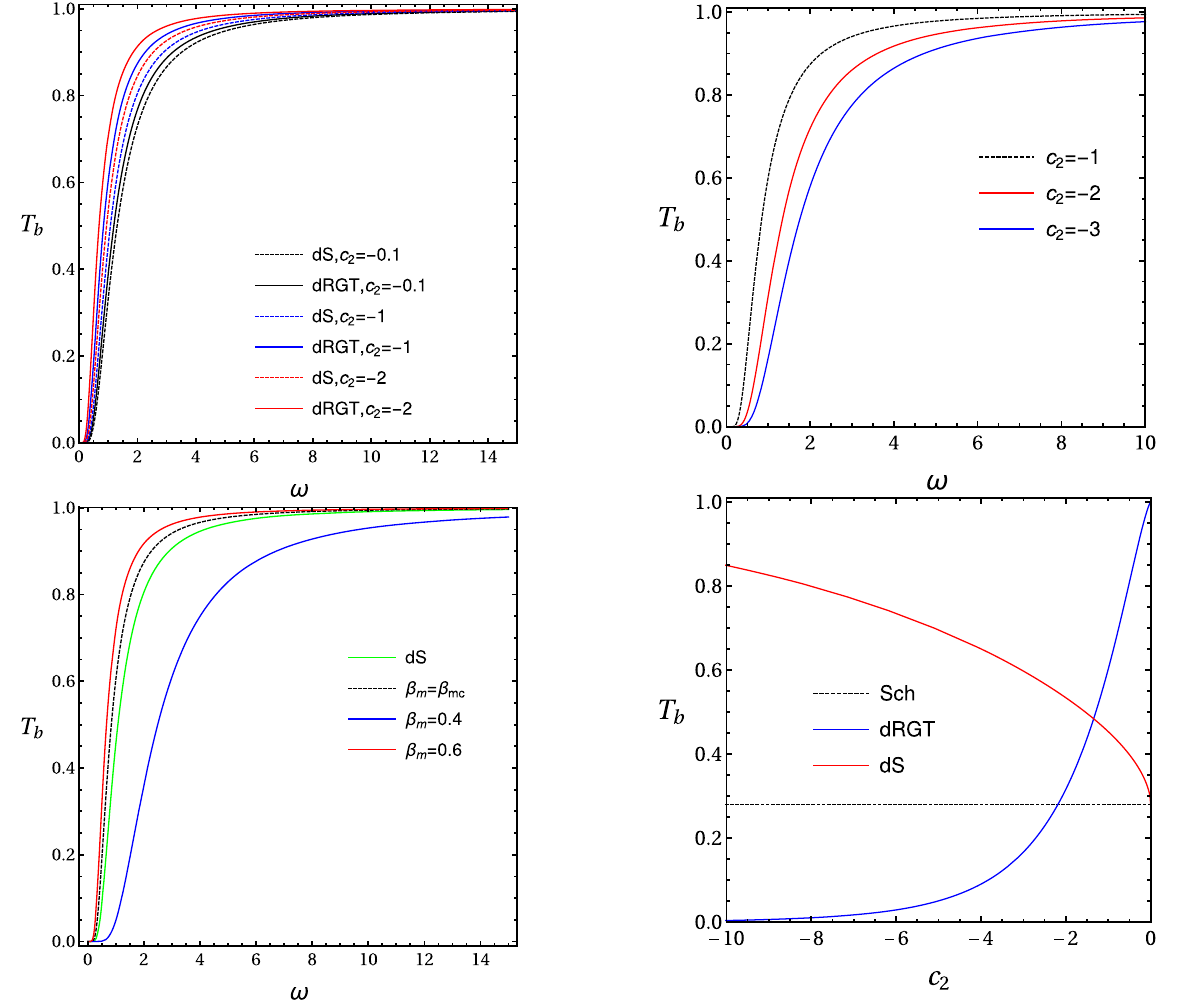
rigorous bound with the greybody factor derived from the matching technique. The results show that the greybody fac- tor obtained from the rigorous bound is less than the one from the matching technique, which means that the rigorous bound is a true lower